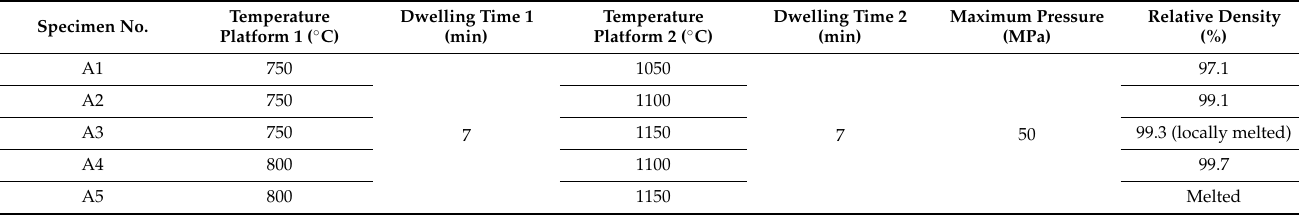
Table 2. Sintering conditions and relative densities of the